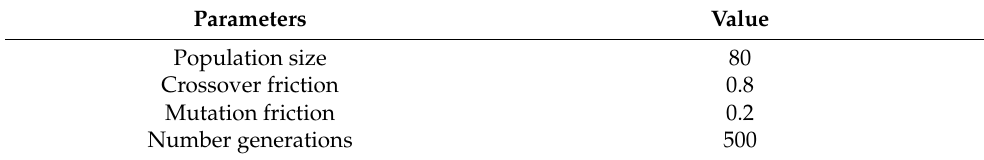
Table 4. The genetic algorithm